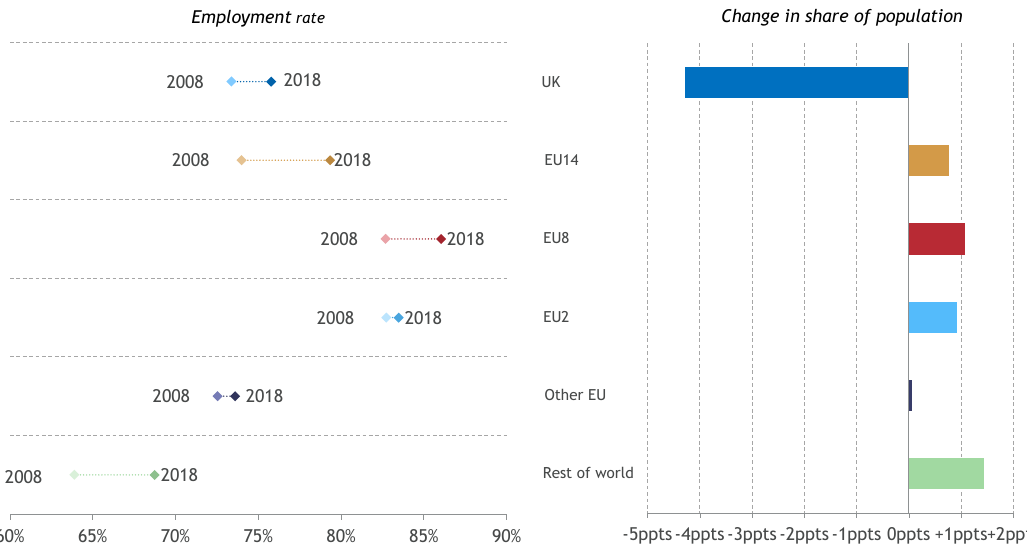
Figure 7: Employment rates have increased for all groups, migrants and those born in the UK Employment and population changes by country of birth, 16-64 year olds: 2008- 18